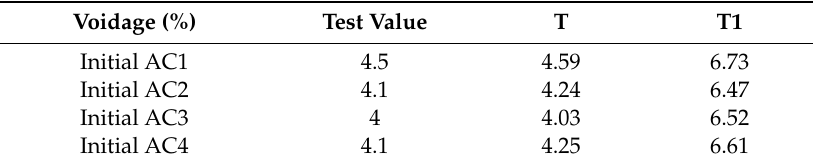
Table 8. Voidage Value and Calculated Voidage Value.